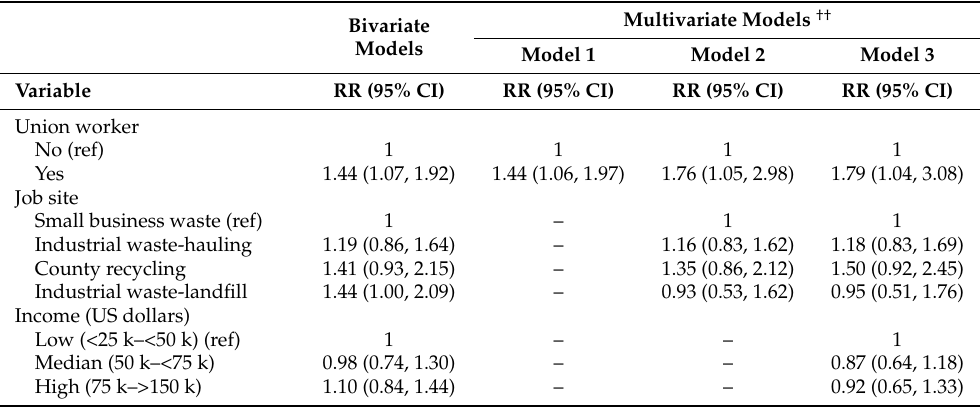
Table 4. Relative risk (RR) of structural factors of effort–reward imbalance (ERI) † . Bivariate